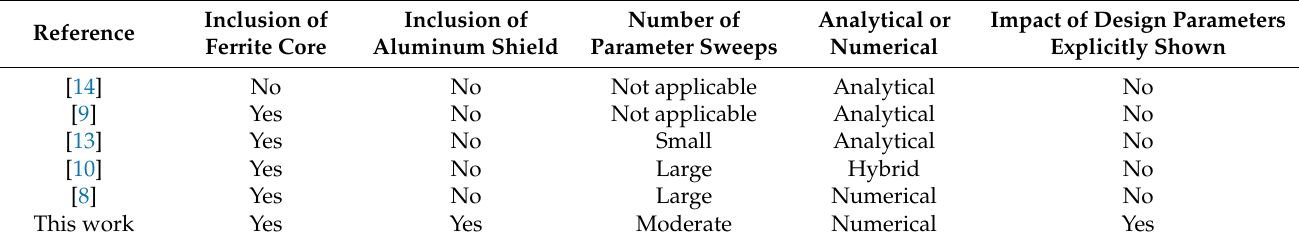
Table 7. Comparisons between this work and relevant works in the